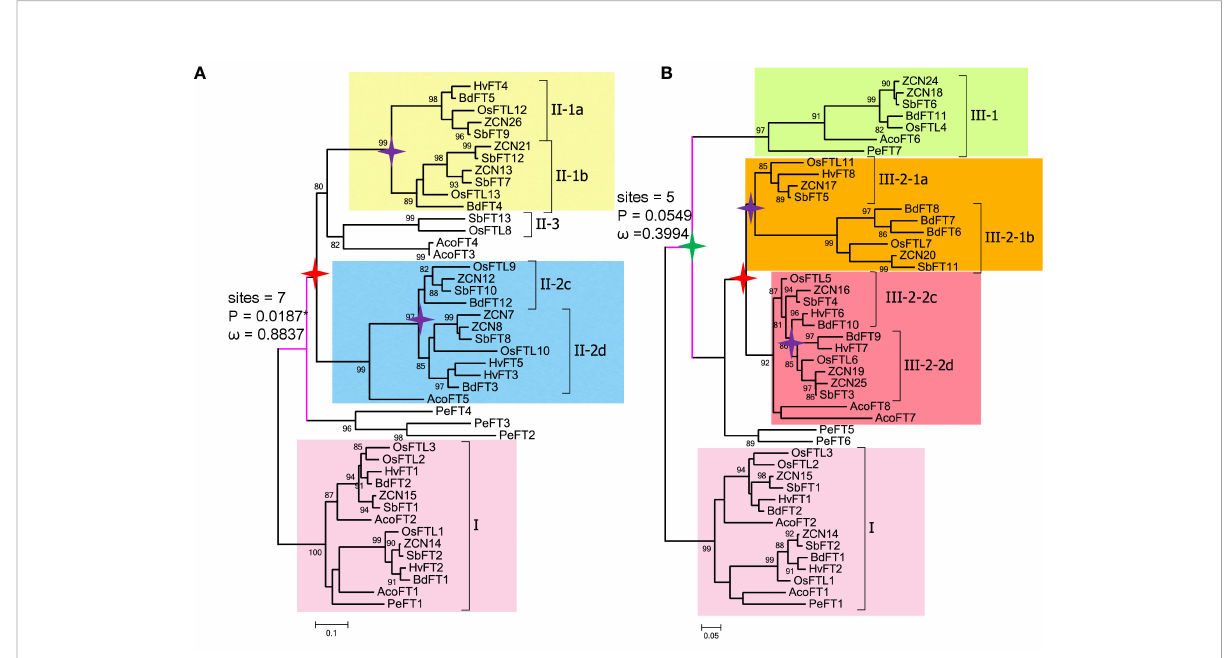
FIGURE 3 Pruned trees consisting of clade I and II (or III) and branch and branch site model tests. (A) Branch and branch site test using clade I as background and clade II as foreground. (B) Branch and branch site test using clade I as background and clade III as foreground. Green star, t WGD; red star, r WGD; and purple star, s WGD. w denotes dN / dS values; sites indicate positive selection sites, P means p-value (probability). Digits in the branches are bootstrap values.